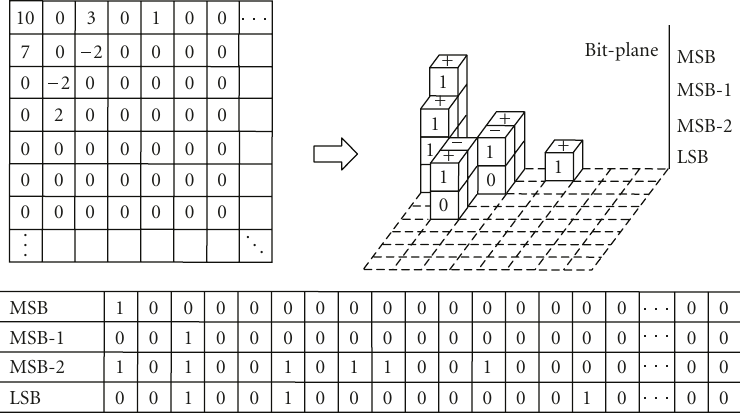
Figure 2: Bit-plane representation of a DCT residue